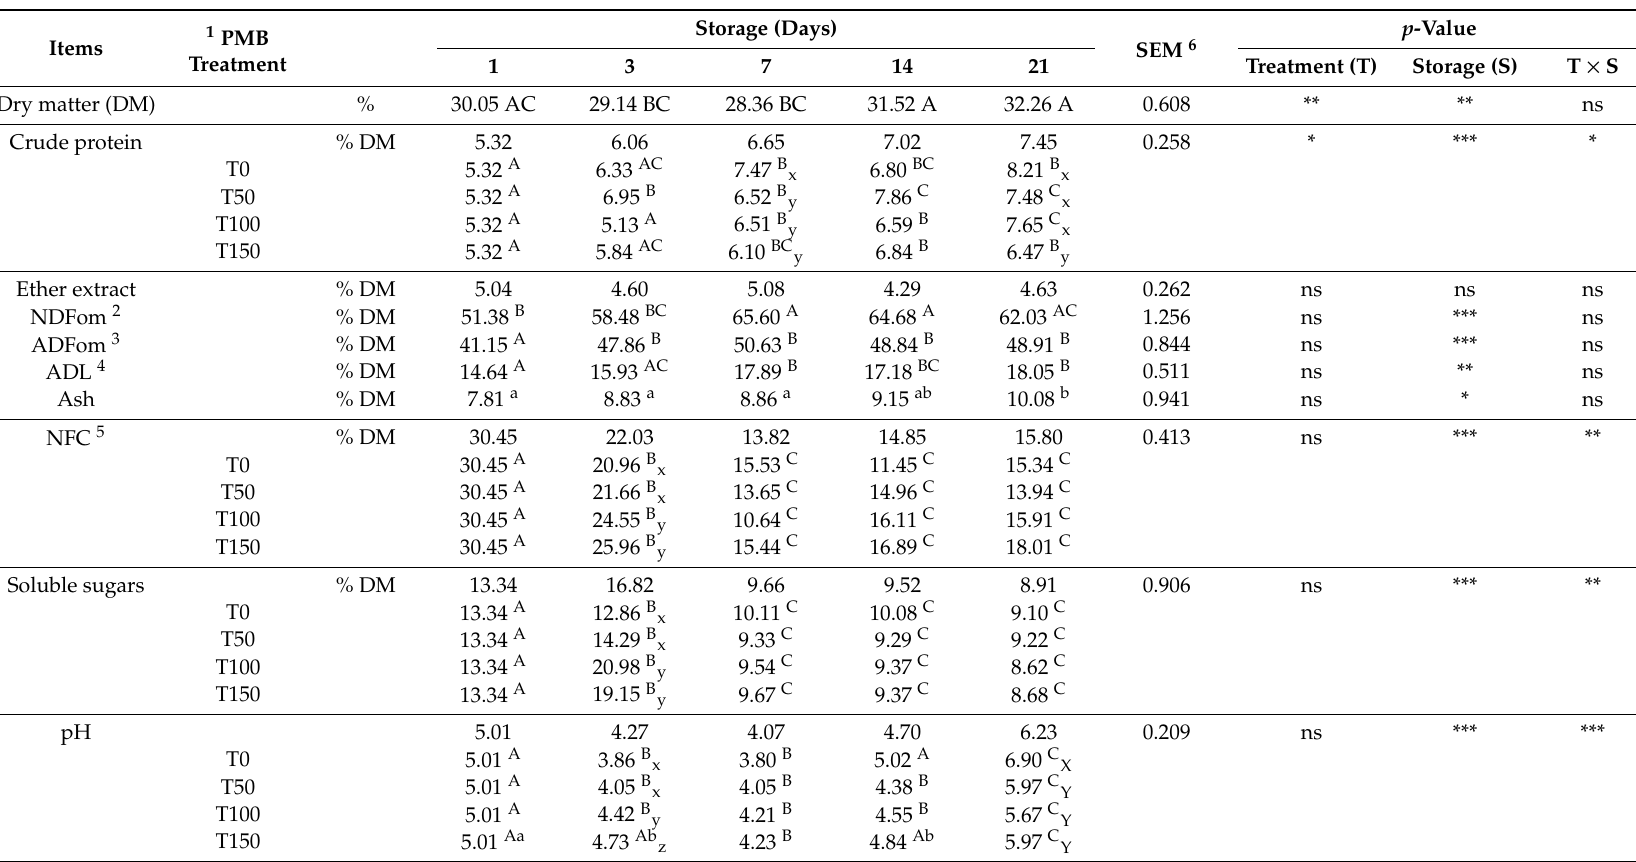
Table 2. Chemical composition of prickly pear by-product (PPB) during storage and in relation to treatments with potassium metabisulfite (PMB) (least square means). Items Dry matter (DM)